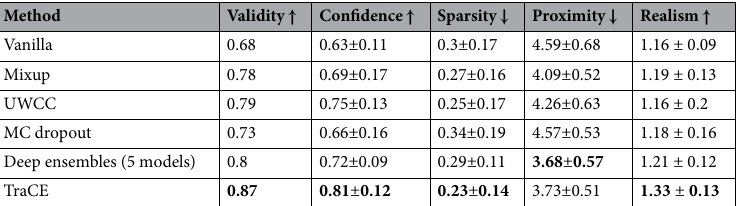
Table 1. Performance evaluation of diagnosis-based counterfactual explanations obtained using different approaches. In each case, we report results averaged across 500 test samples. Significant values are in [bold].